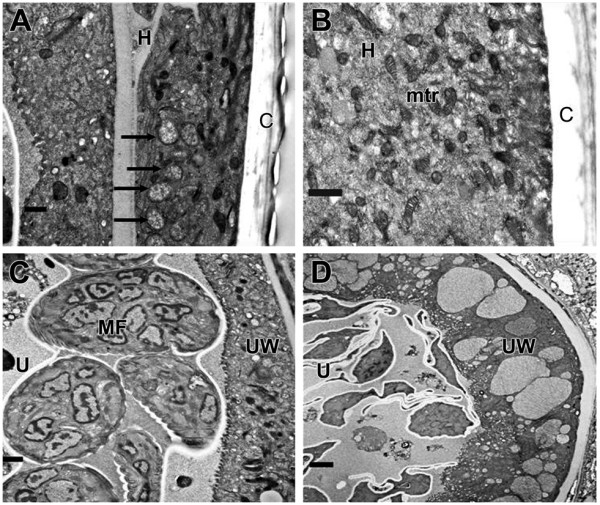
Transmission electron micrographs of Brugia malayi female worms. Panel A and C are sections of untreated female worm. Panel A shows numerous Wolbachia (arrows) in the hypodermis. Panel C shows, intact embryos in the uterus. Panel B and D are sections from doxycycline treated worms. The hypodermis is free of Wolbachia (Panel B) and only degenerate embryos were present in the uterus of treated worms (Panel D). U, uterus; C, cuticle; UW, uterine wall; MF, microfilaria; mtr, mitochondria. Scale bar = 1 μm.